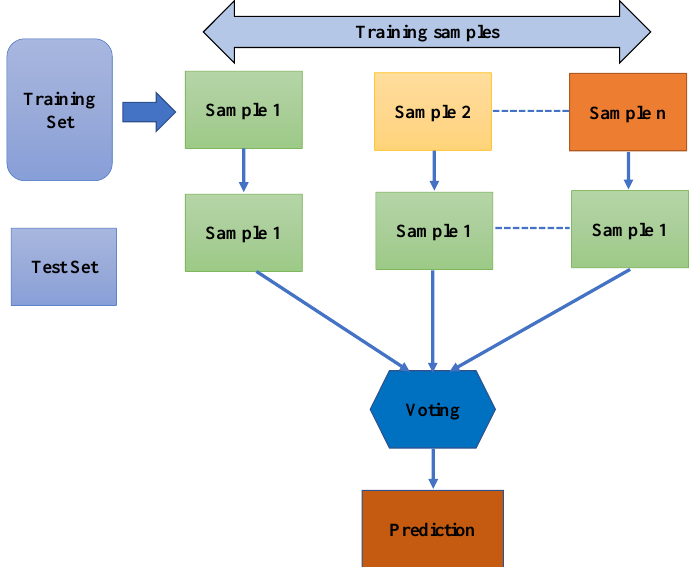
Figure 4. Execution process of the RF model for the required outcome.